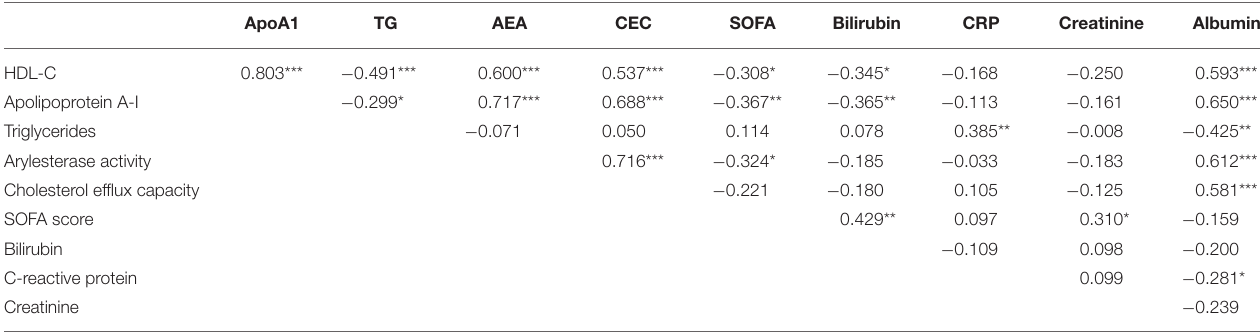
TABLE 2 | Correlation matrix of lipid parameters and selected covariables in the sepsis